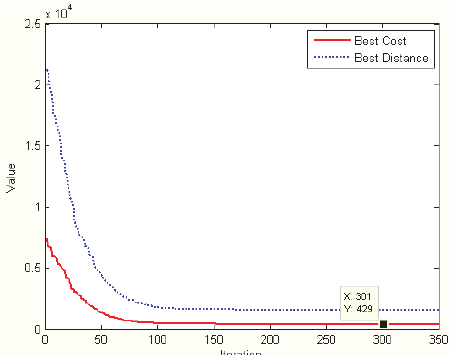
Fig. 10. Problem solution (two independent objective functions)